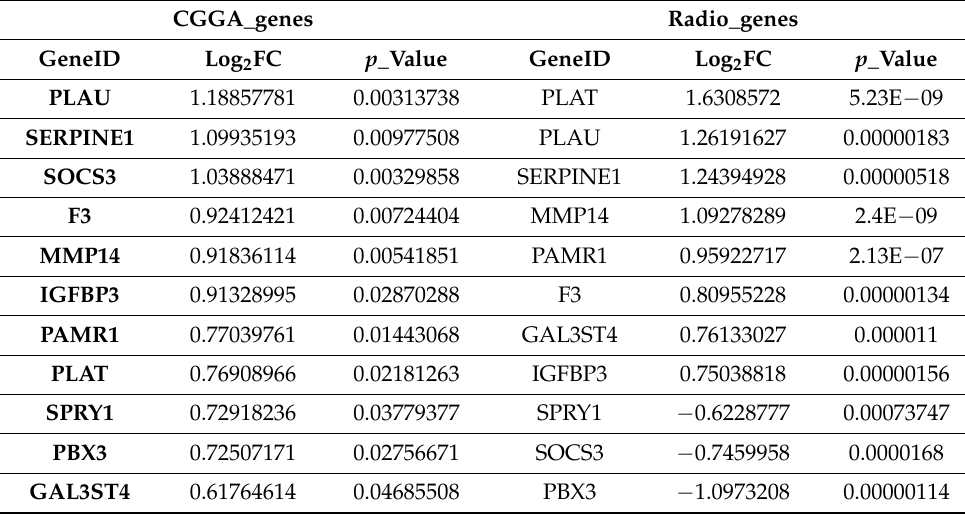
Table 1. Eleven candidate genes of “CGGA_genes” and